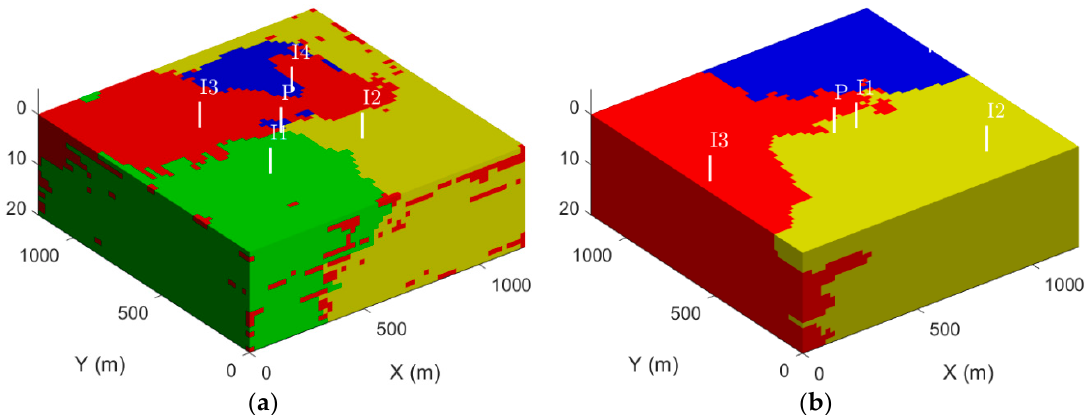
Figure 14. Injection well positions, plotted in white lines, and their capture zones for the ( a ) initial and ( b ) optimal P&T designs in the three-dimensional heterogeneous aquifer.